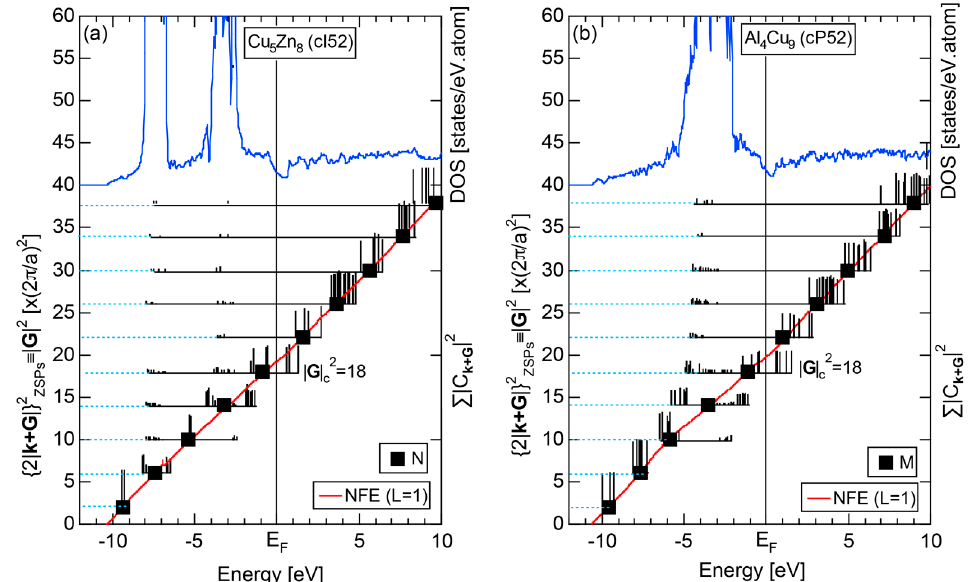
Figure 36. ( a ) FLAPW-Fourier spectra at symmetry points N of the bcc Brillouin zone along with the total DOS for Cu 5 Zn 8 (cI52) and ( b ) those at symmetry points M of the simple cubic (sc) lattice Brillouin zone for Al 4 Cu 9 (cP52) [11].